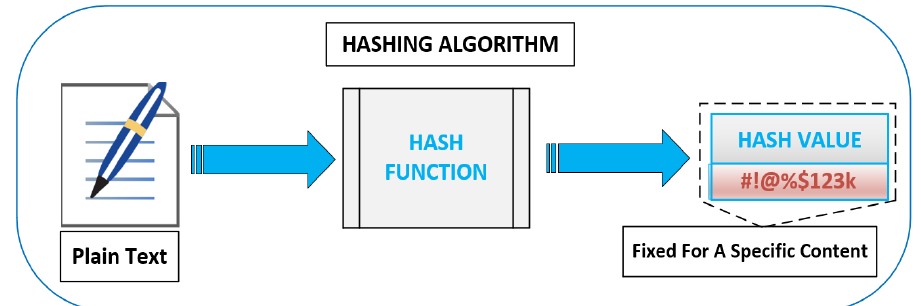
Figure 4. The hash function: plain text to hash value.